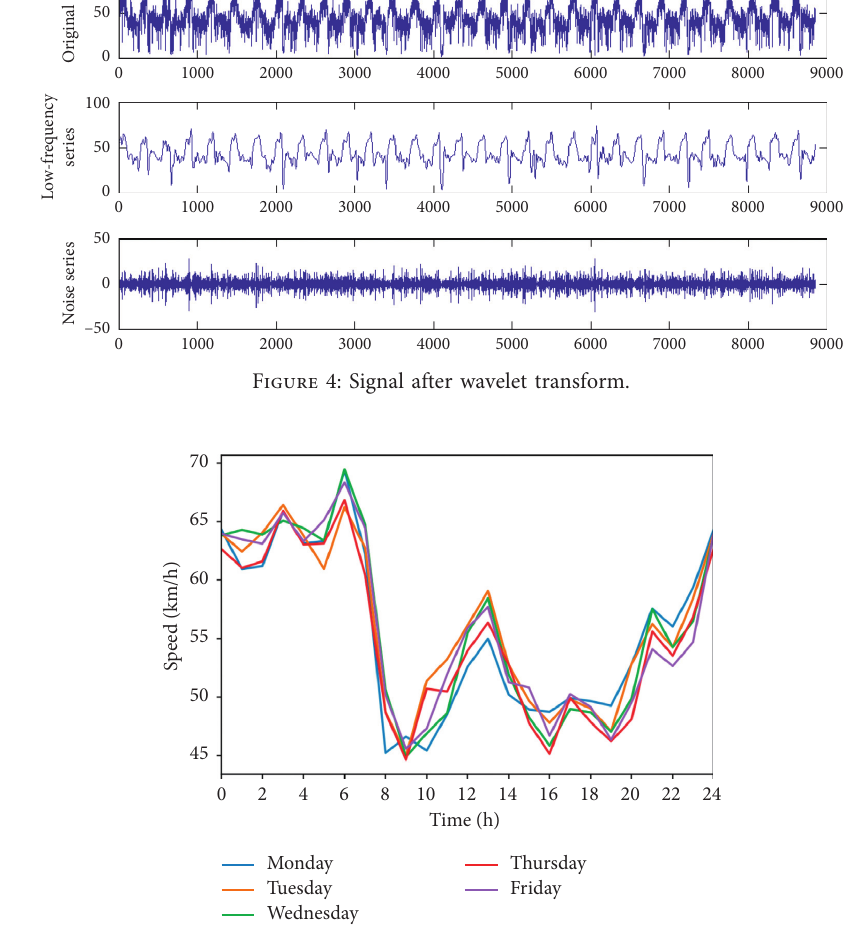
Figure 5: Comparison of trend signals on weekdays.